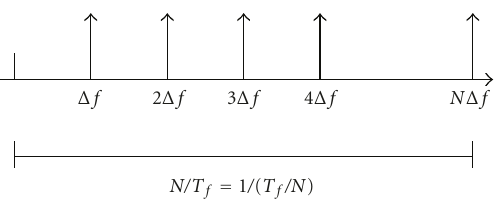
Figure 2: CI waveform in